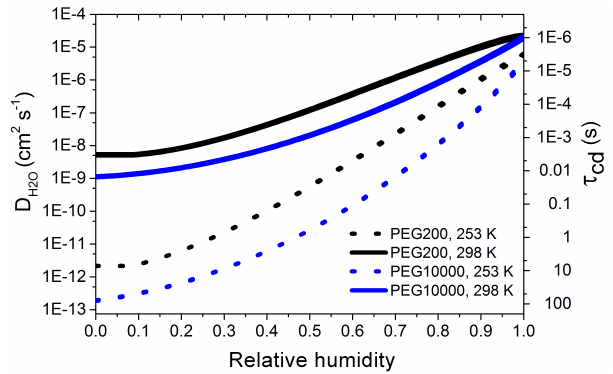
) and character- 2 0